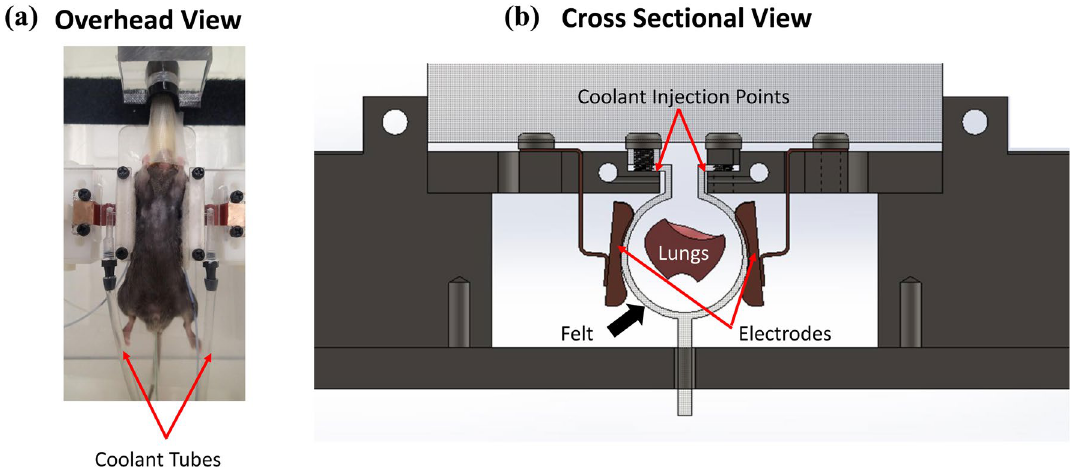
Figure 2. Gross image of the RF device. ( a ) The overhead view of the mouse positioning. The mouse was set between the electrodes and was supported by a felt over which cool saline was dispensed during the RF treatment. ( b ) The cross-sectional view of the RF device. The electrodes were designed to match the position of the